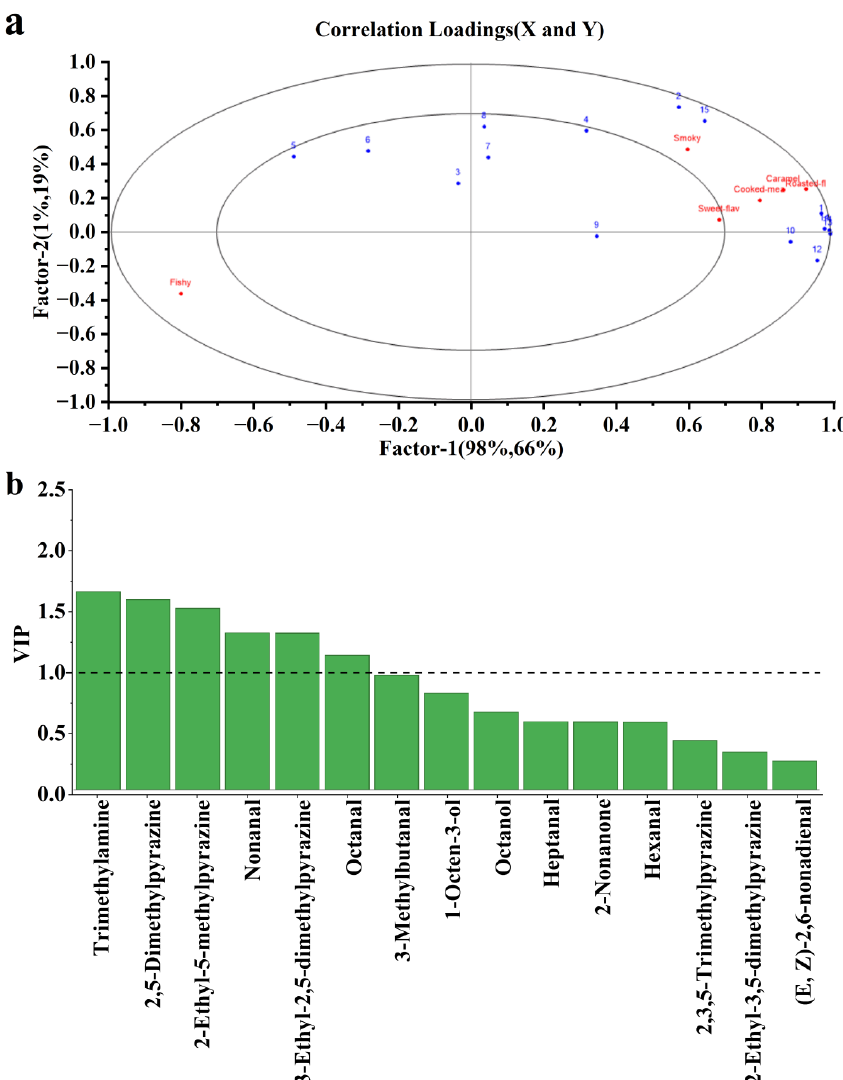
Figure 4. PLSR correlation loadings plot of different dried shrimp AACS and sensory attributes ( a ),